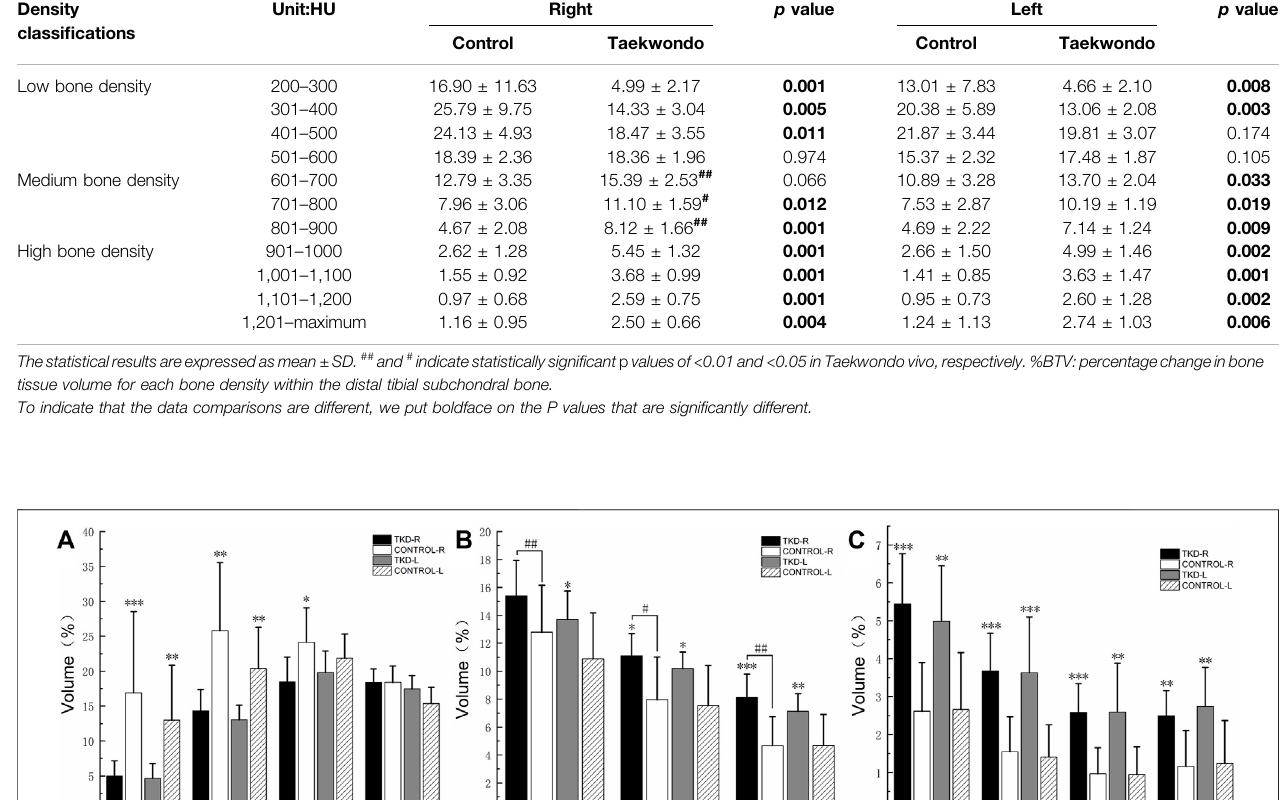
TABLE 3 | Comparison of the bone volume of each bone density zone in the distal tibia subchondral bone between the groups (%). Density Unit:HU Right p value Left p value classi fi cations Control Taekwondo Control Taekwondo Low bone density